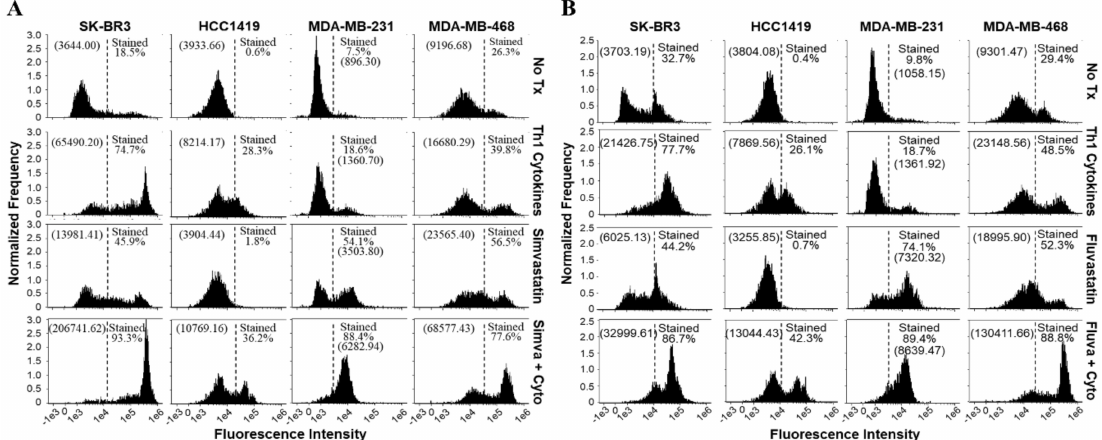
Figure 6. Cells treated with a statin drug and Th1 cytokines demonstrate enhanced activation of caspase 3 / 7. SK-BR-3, HCC1419, MDA-MB-231, and MDA-MB-468 human breast cancer cell lines